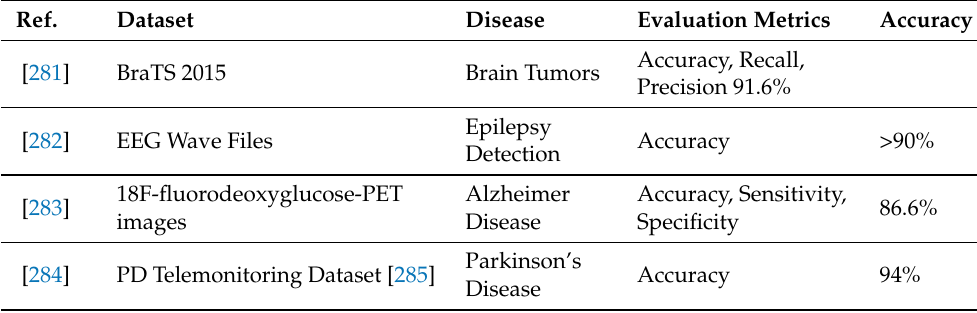
Table 20. DBN classifier result analysis on various